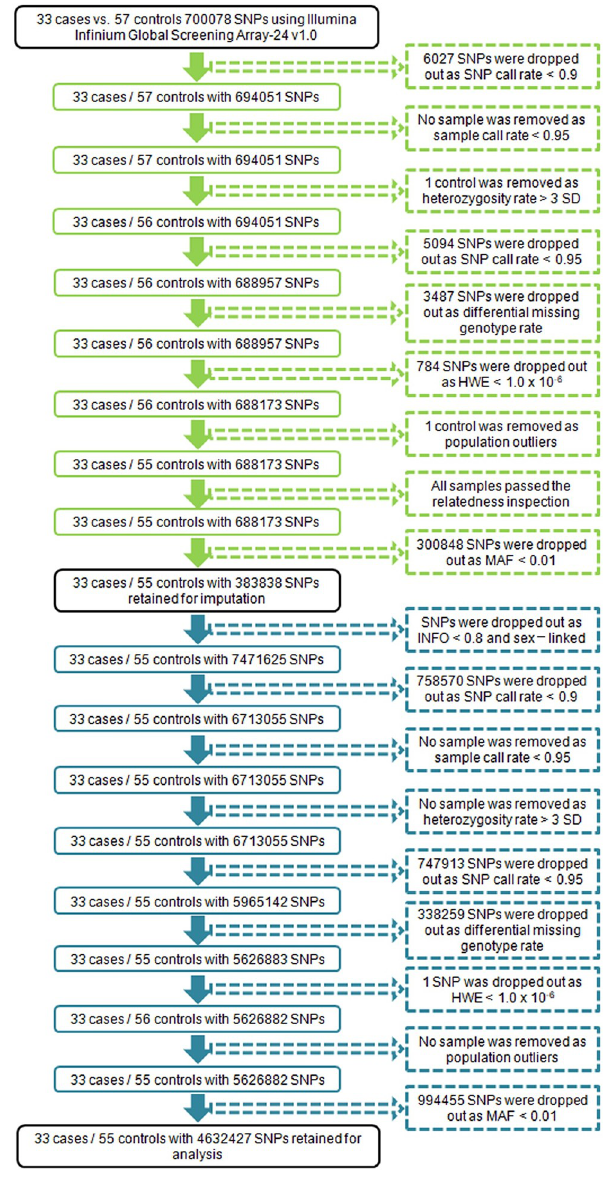
Fig 1. Workflow of the quality control process of genotypes data. The pre-imputation quality control steps are marked in green, and 383,838 SNPs passed the criteria. The post-imputation quality control processes are marked in